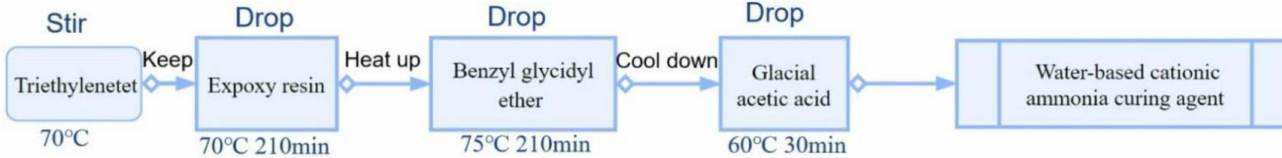
Figure 2. Synthesis method of curing agent.